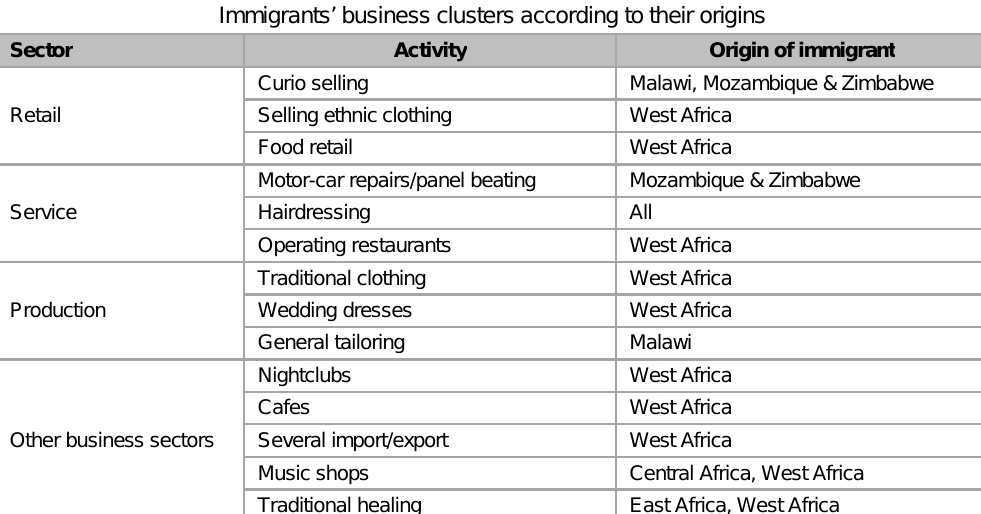
Source: Table adapted from Rogerson’s text above in